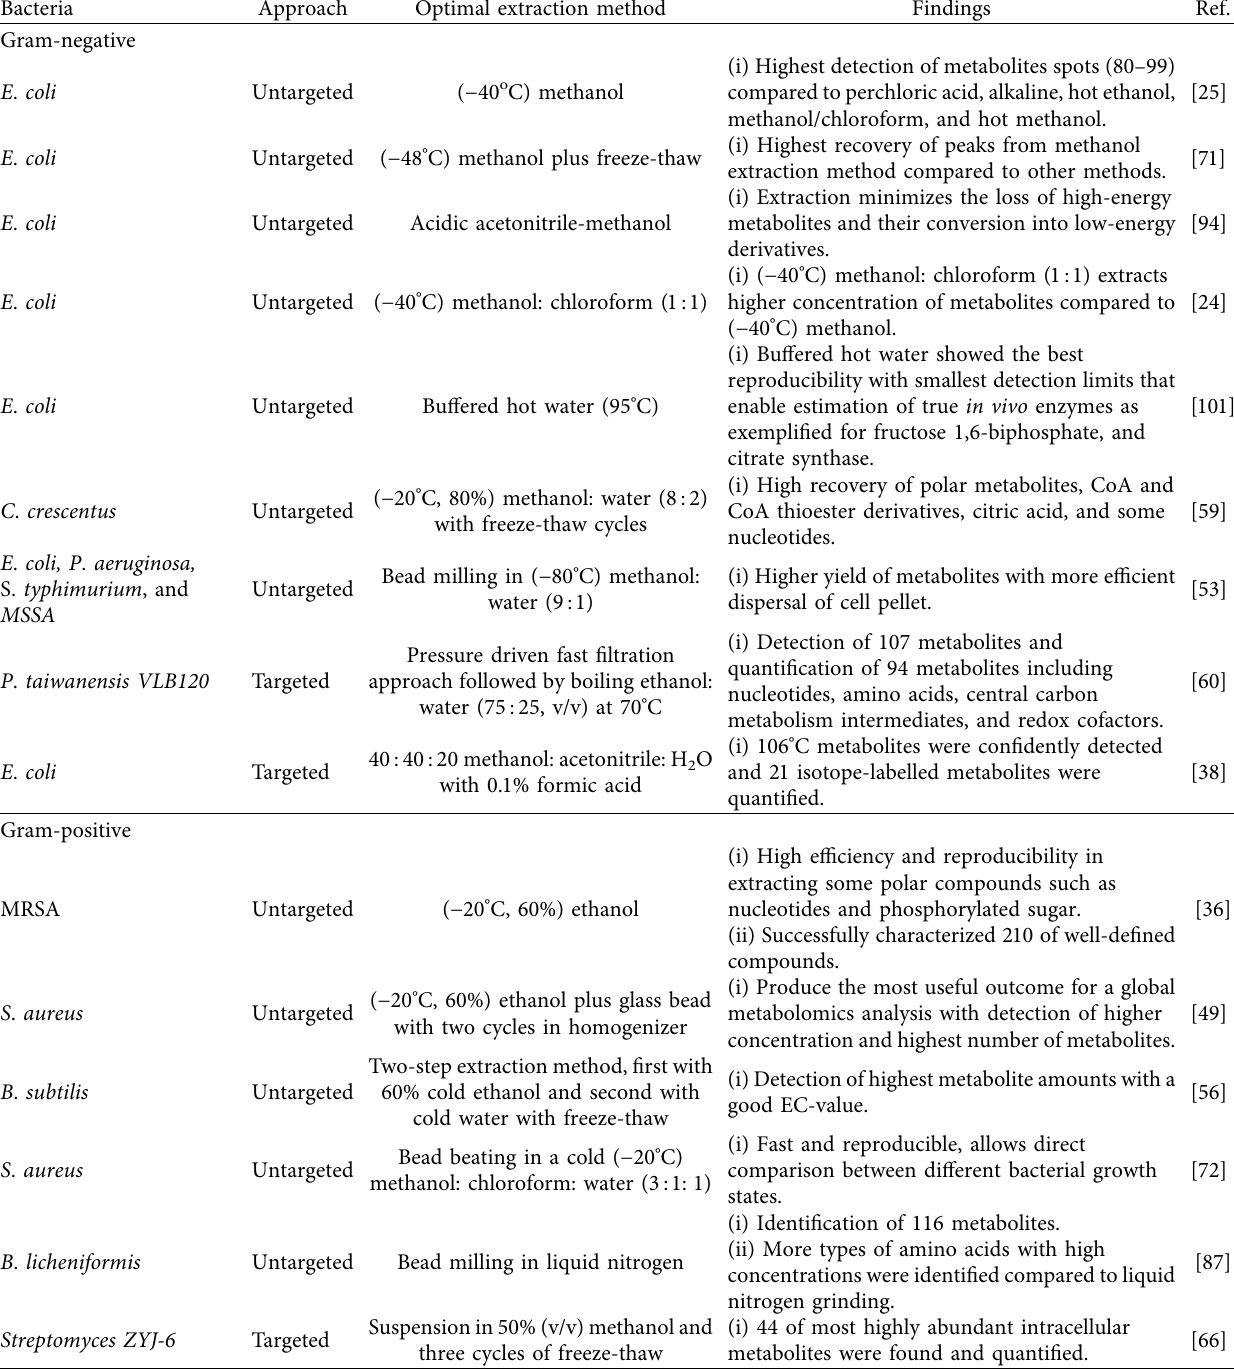
Table 2: Summary of optimized extraction methods for bacterial metabolomics studies. Bacteria Findings